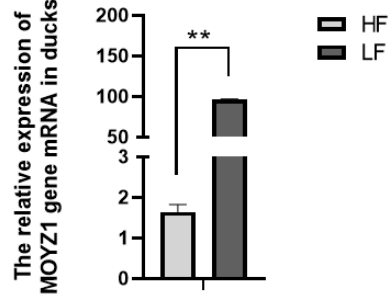
Figure 1. Relative mRNA expression of MYOZ1 in HF and LF groups. ** indicates that the difference is extremely significant ( p < 0.01). 3.3. Relative Expression of MYOZ1 Protein in HF and LF Groups Western blot was used to detect the expression of MYOZ1 and GAPDH proteins in breast muscle tissue, and the WB results were analyzed using ImageJ software. The results are shown in Figure 2. The results showed that the expression of MYOZ1 protein in the HF group was significantly lower than that in the LF group ( p < 0.01). Figure 2. Expression of MYOZ1 and GAPDH proteins in meat ducks with high and low feed con- version ratios. ( A ) Typical map of Western blot. ( B ) Western blot gray value statistics. ** indicates that the difference is extremely significant ( p < 0.01). 3.4. Analysis of Single Nucleotide Polymorphisms in MYOZ1 To verify the relationship between the SNP locus of MYOZ1 and the feed conversion ratio, blood samples were collected from 100 ducks for DNA extraction. Three pairs of primers were designed to amplify MYOZ1 fragments (Table 2). Two SNPs were identified using pool DNA or individual DNA sequencing, and part of the sequencing peak map is shown in Figure 3.